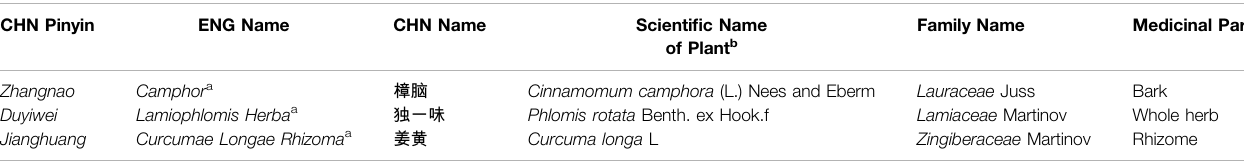
TABLE 1 | Composition of the Tibetan herbal pain-relieving